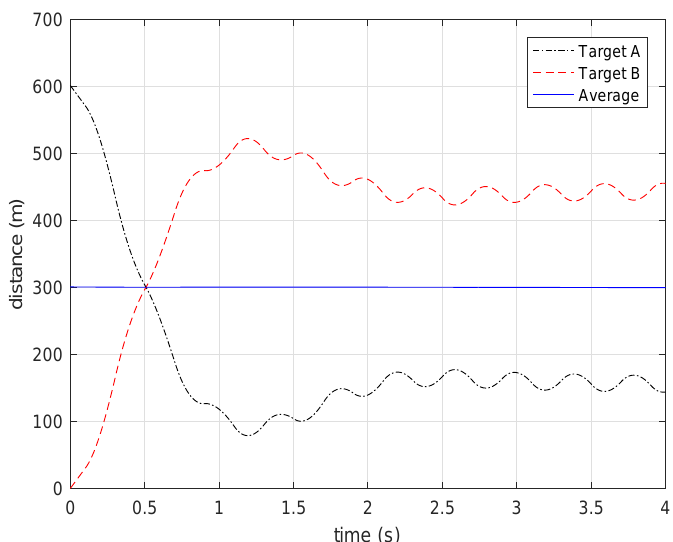
Figure 21. The miss distance, defined as the distance between the tracking point at the target range and its actual location, for targets A and B , as well as their average.